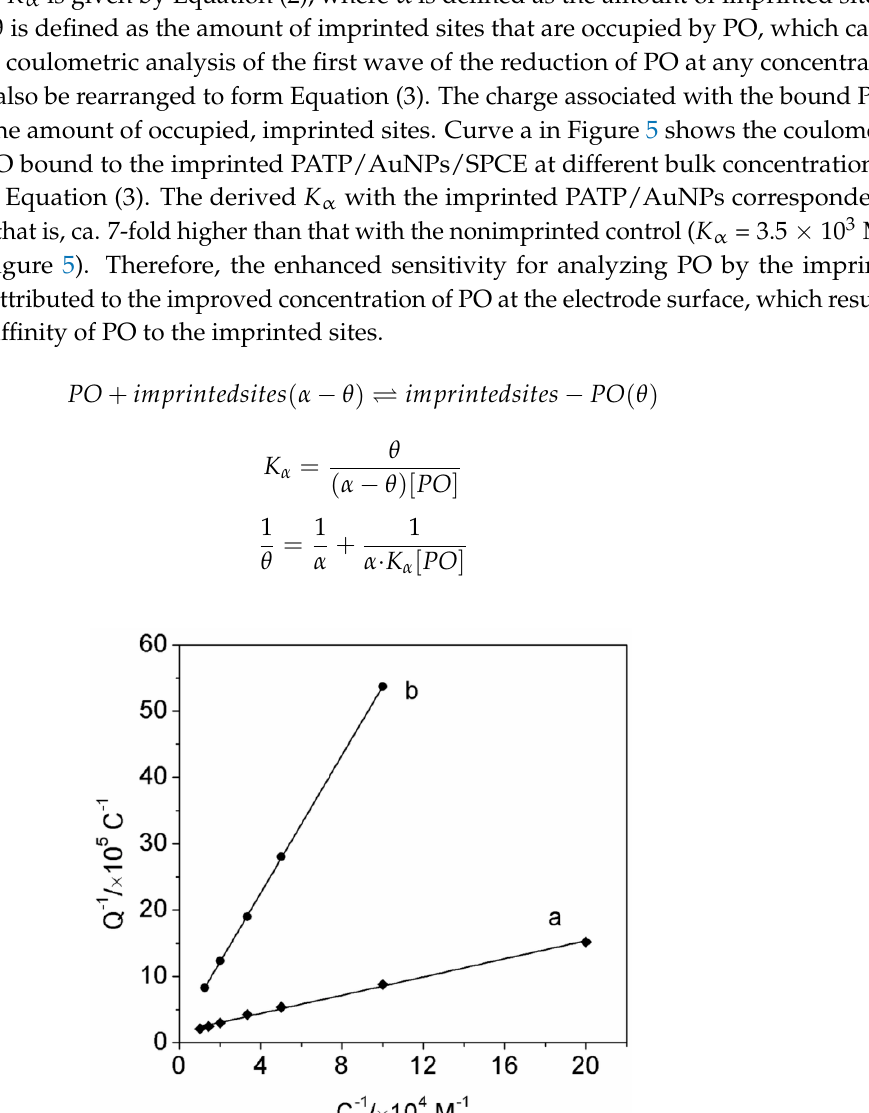
Figure 6 . Calibration curves corresponding to the analysis of PO (curve a) and PT (curve b) by the imprinted PATP/AuNPs/SPCE. All data were recorded after interacting the respective electrode with the PO or PT solution sample for 10 min. The competitive selectivity property to PO of the developed sensor was evaluated by testing its DPV responses in the presence of some possible interfering substances, including PT, monocrotophos (MC), isocarbophos (IC), and p -nitrophenol ( p -NP), respectively. The competitive selectivity of the imprinted PATP/AuNPs/SPCE electrode to PO molecules was evaluated by